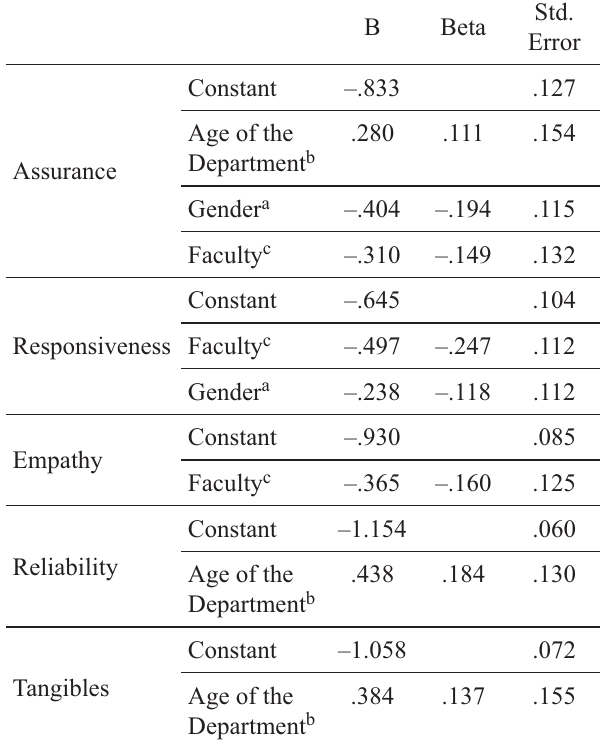
Table 8. Stepwise regressions of SERVQUAL dimensions vs. demographics and educational characteristics